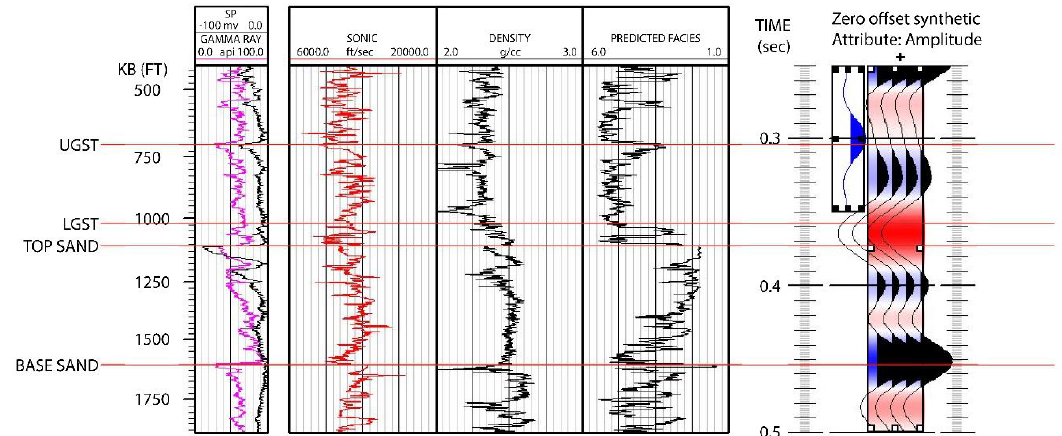
Figure 7. Correlation between synthetic seismic and predicted facies for the SeaBee-1 well.